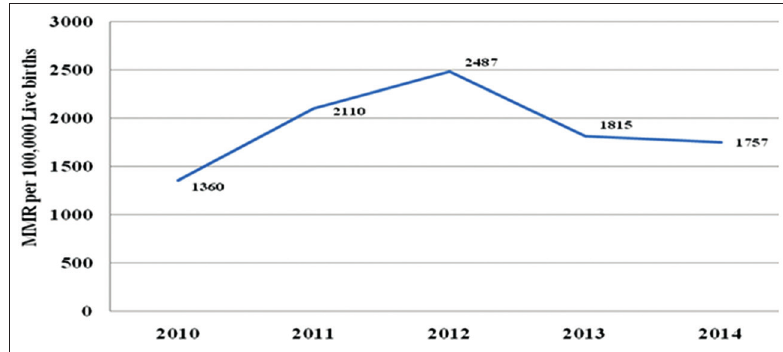
Figure 1 : Trend of MMR per 100,000 live births, 2010 - 2014, Menongue, Kuando Kubango